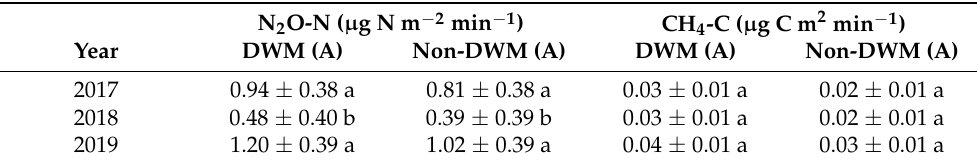
Table 1. Mixed-effects model results for N 2 O-N and CH 4 -C mean fluxes ( ± SE) aggregated by year and treatment. For N 2 O-N, years 2017 and 2019 were significantly different from 2018, but not significantly different from each other. The effects of year and DWM treatment were not significant for CH 4 fluxes.